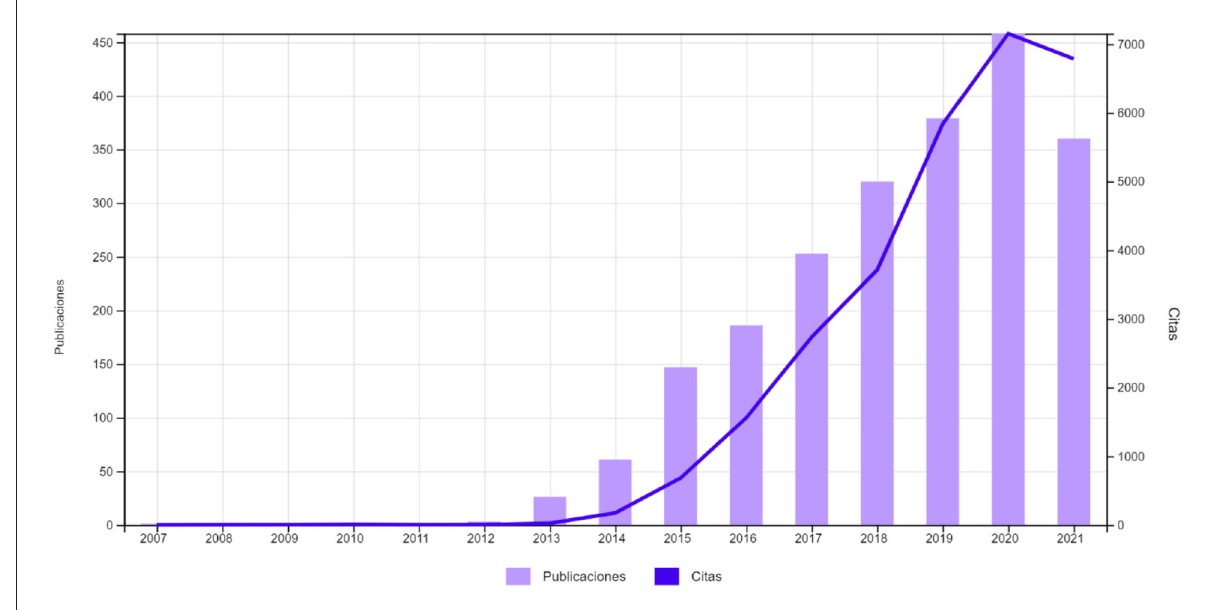
FIGURE2 Number of publications and citations. Source: Web of Science.